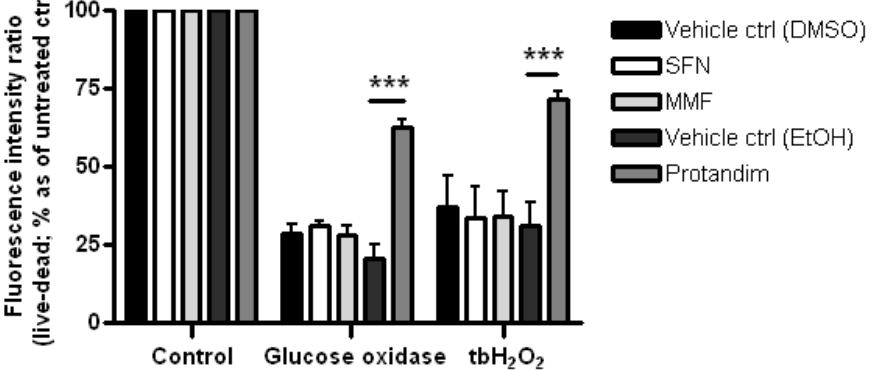
Figure 5. Protandim promotes viability of mature primary rat OLs under oxidative insult. Mature primary rat OLs differentiated for 7 days were treated for 24 h with 5 µ M SFN, 90 µ M MMF,30 µ g/mL Protandim or their respective DMSO or EtOH vehicle control. After removal of medium, cells were subsequently exposed to either control medium or medium with 100 µ M tert-butyl hydrogen peroxide (tbH 2 O 2 ) or glucose oxidase (1:750,000). Cell viability was measured using an Invitrogen live/dead cytotoxicity kit. Data are presented as percentage of control and expressed as the mean ± SEM of 3 independent experiments. Statistics reflect one-way ANOVA test with post hoc Bonferroni correction; *** p < 0.05.